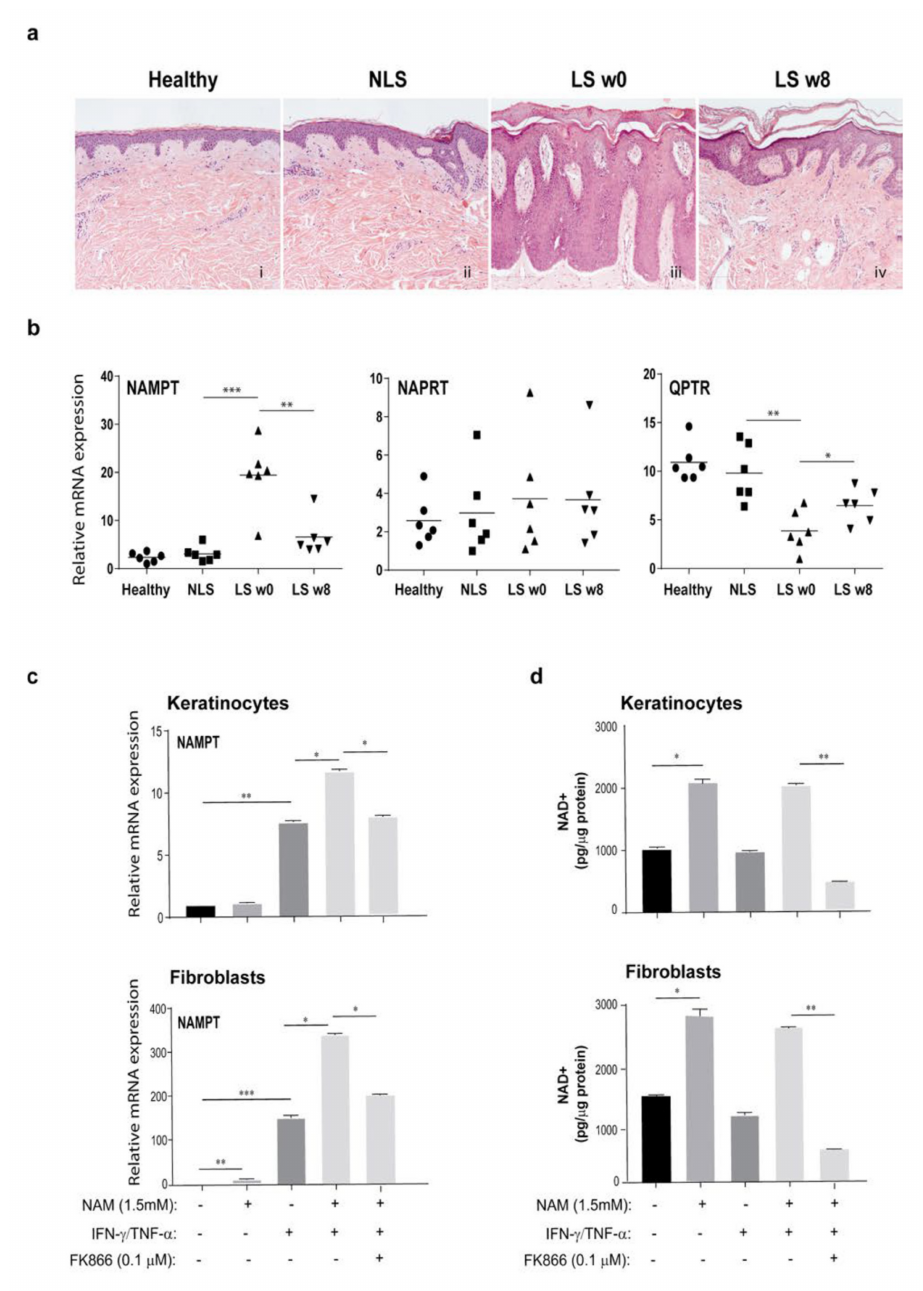
Figure 2. NAMPT mRNA levels are up-regulated in vivo in skin of psoriatic patients and induced in vitro in keratinocytes and dermal fibroblasts by combination of IFN- γ and TNF- α with NAM. ( a ) The histopathological features of psoriasis were examined in psoriatic skin ( n = 6), including non-lesional (NLS, ii), lesional (LS) zones of evolving plaques, before (week 0, w0) (iii) and after 8 weeks (w8) (iv) of secukinumab treatment, counterstained with Mayer’s hematoxylin and eosin (H&E). One out of six representative stainings of psoriatic skin biopsies are shown. Specimens from healthy skin was also included (i). Bars, 100 µ m. ( b ) mRNA expression of NAMPT, NAPRT, and QPRT were analyzed by RT-PCR on healthy, NLS, LS w0, and LS w8 biopsies ( n = 6) and normalized to HPRT1 levels. Statistical significance was assessed by Mann–Whitney U test, * p ≤ 0.05, ** p ≤ 0.01, and *** p ≤ 0.001. ( c , d ) Keratinocyte and fibroblast cultures were left untreated or treated with a combination of IFN- γ /TNF- α in presence or absence of NAM (1.5 mM) for 24 h. Keratinocytes and fibroblasts activated by cytokines in presence of NAM were concomitantly exposed to FK866 (0.1 µ M). ( c ) NAMPT mRNA expression was analyzed by RT-PCR and normalized to HPRT1 levels. ( d ) NAD + levels were quantified by colorimetric assay and expressed as mean of pg/ µ g of total proteins. All data shown are the mean of three different experiments ± SD. Statistical significance was assessed by paired Student’s t test, * p ≤ 0.05, ** p ≤ 0.01, and *** p ≤